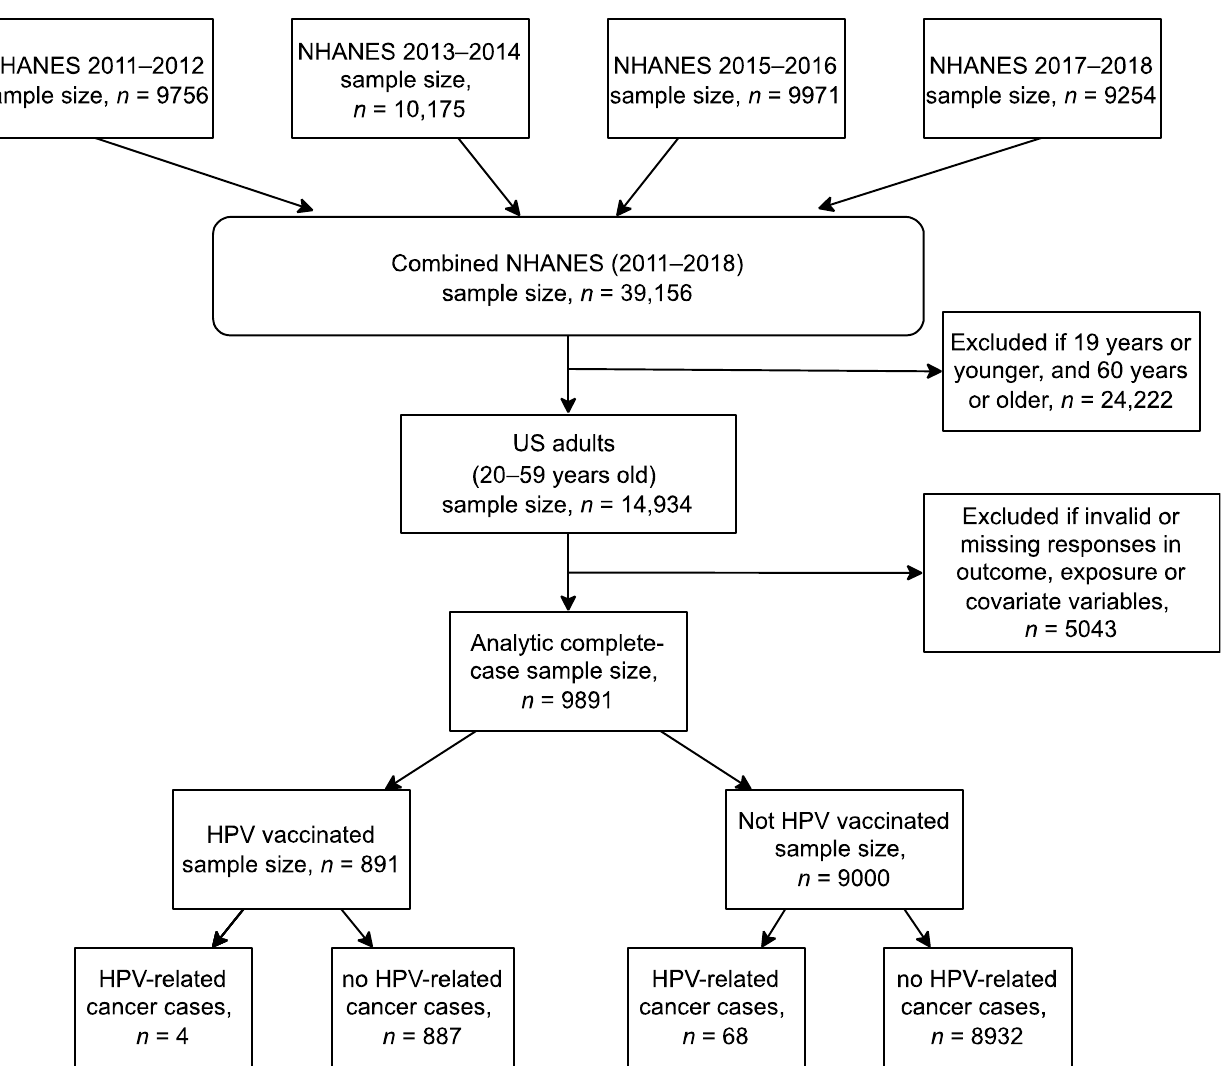
Figure 1. Flowchart describing the analytic complete case sample selection for a study investigating the relationship of HPV vaccination to HPV-related cancers using data from the National Health and Nutrition Examination Survey (NHANES) between 2011 through 2018. Abbreviations: U.S.: the United States; HPV: human papillomavirus.